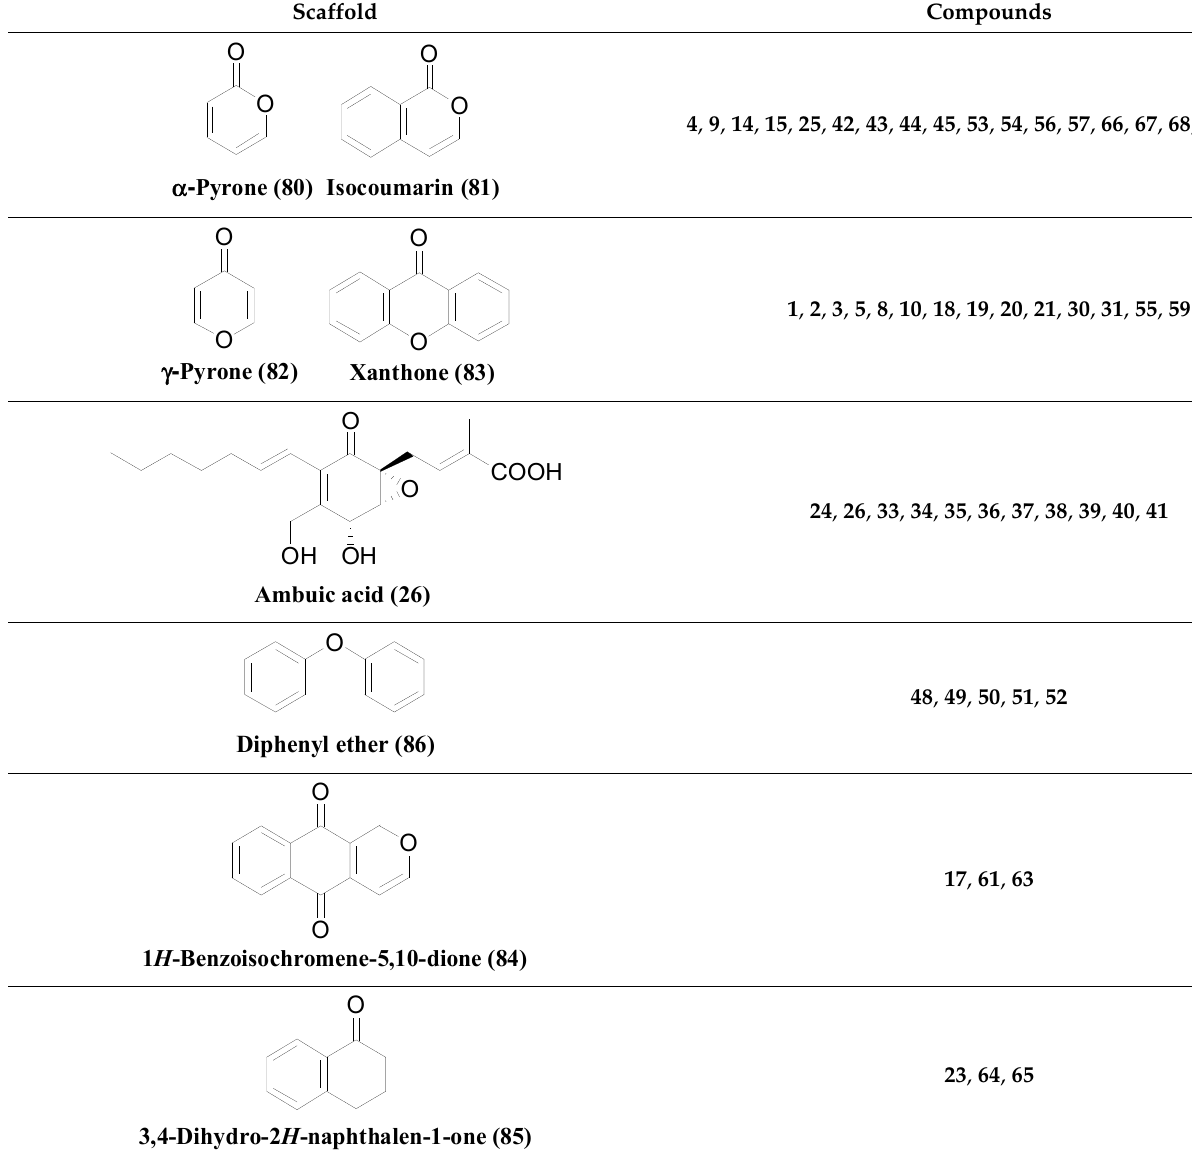
Table 2. Common structural scaffolds among the antimicrobial compounds isolated from ELF.